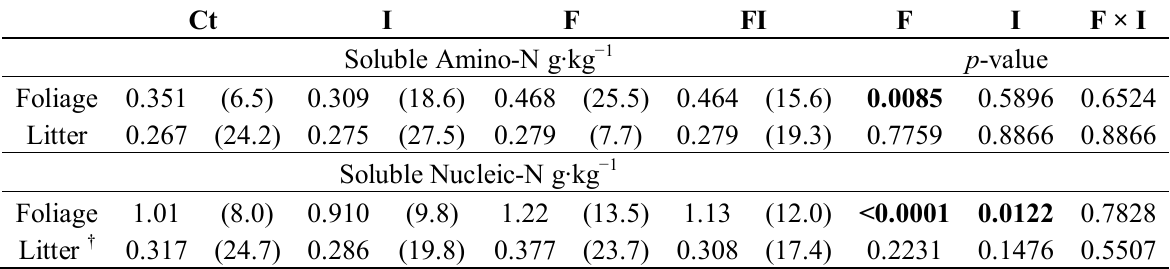
Table 1. Mean loblolly pine foliage and litter nitrogen fraction concentrations in control (Ct), irrigation (I), fertilization (F), and fertilization × irrigation (F × I) treatments. Coefficients of variation are shown in parentheses. Soluble amino-N is cold 0.30